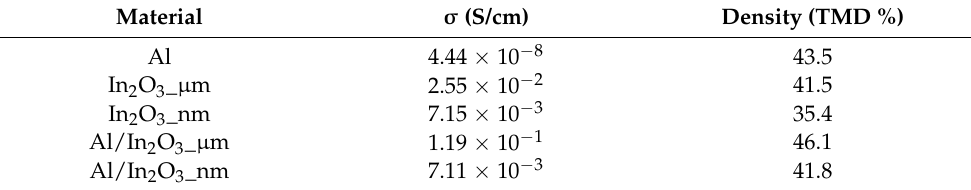
Table 2. Electrical conductivity of the aluminum, indium (III) oxide powders and aluminum/indium (III) oxide energetic composite materials (at an equivalence ratio φ of 1). The density of the pelletized samples is expresses in term of TMD % where TMD represents the theoretical maximum density of the sample.